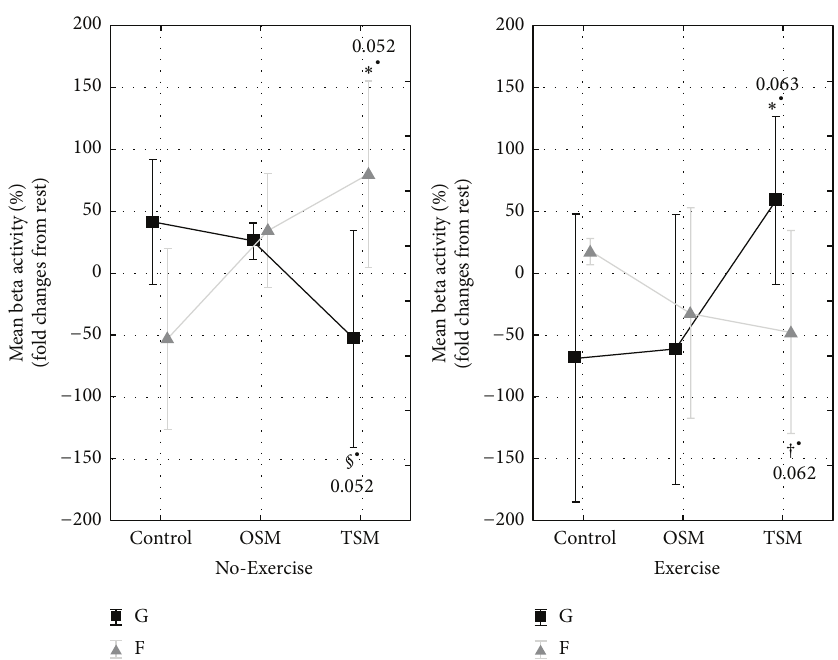
Figure 4: Mean beta activity (12.5–35.0 Hz), expressed as relative change (%) from rest over global (G; black lines) and frontal (F; grey lines) electrode sites. Mean EEG activity was measured before (rest) and following No-Exercise (automatic drive) and Exercise (moderate cycling) trials within three levels of virtual environment exposure (Control; OSM: one-screen mode; TSM: three-screen mode). ∗ ∙ indicates a trend compared with Control ( 𝑝 < 0.1 ); † ∙ indicates difference between Exercise and No-Exercise trials ( 𝑝 < 0.1 ); § ∙ indicates difference between F and G ( 𝑝 < 0.05 ). Data are mean ± 0.95 CI ( 𝑛 = 18 ).